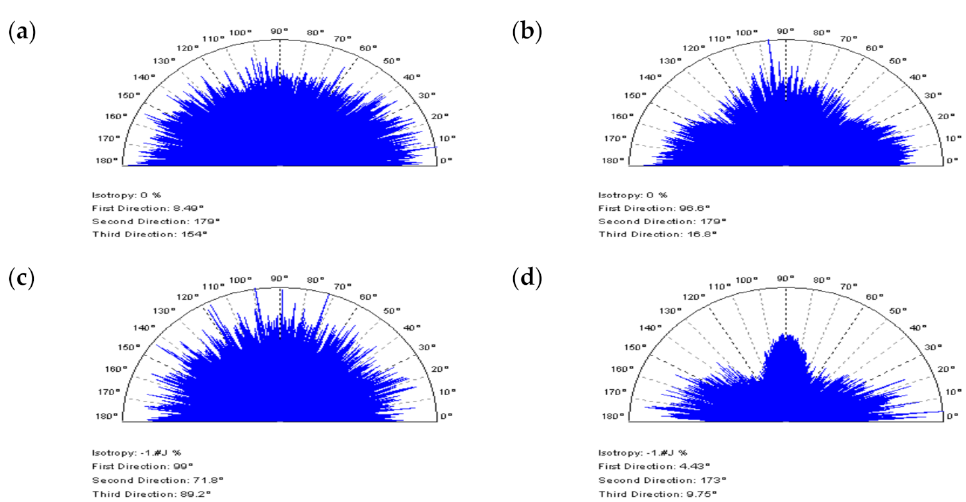
Figure 16. Texture direction graphs of NSs obtained for the composite surface texture with the application of ( a ) CSSF, ( b ) OPGF, ( c ) OPSF, and ( d )